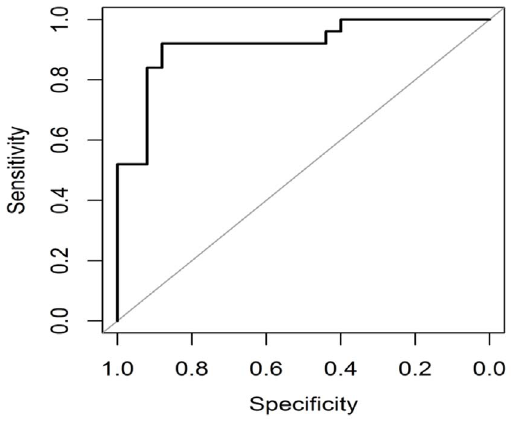
Figure 8. ROC plot for classification between TB and non-TB CXRs (DA) using PHOG features.